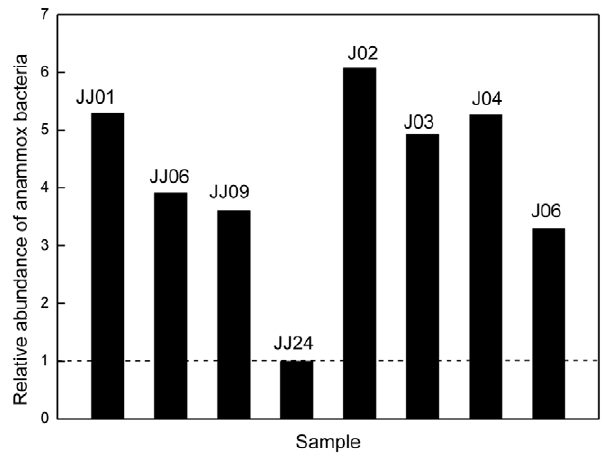
Figure 5. Relative abundances of anammox bacteria in different samples from the Jiaojiang